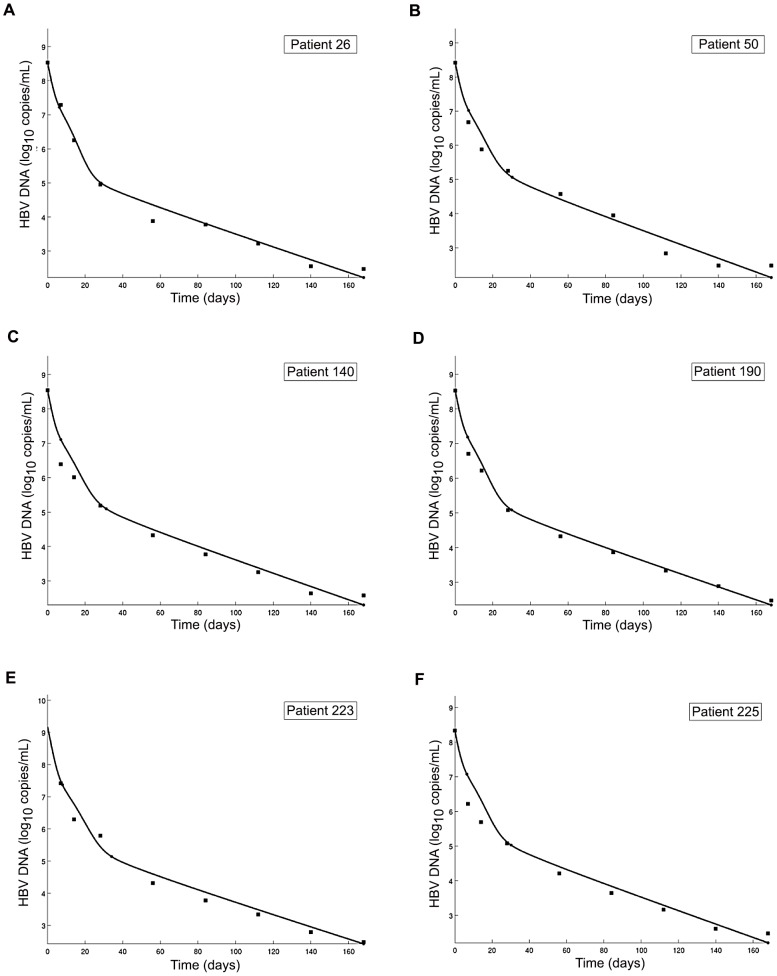
Examples of viral decay patterns with fitted curves during 24 weeks of clevudine therapy (Fig. 1-A–F).Squares represent quantified values of HBV DNA, and solid lines indicate fitted curves according to the modeling of viral dynamics in each patient. Baseline patient profiles (sex (M, male; F, female)/age/HBV DNA (Log10 copies/mL)/ALT (IU/L)/HBsAg (Log10 IU/mL)) are as follows: Patient 26, F/51/8.53/135/3.68; Patient 50, M/38/8.42/78/4.01; Patient 140, F/50/8.54/204/4.35; Patient 190, M/52/8.53/83/4.31; Patient 223, F/53/9.17/46/4.32; Patient 225, F/40/8.33/88/4.12.